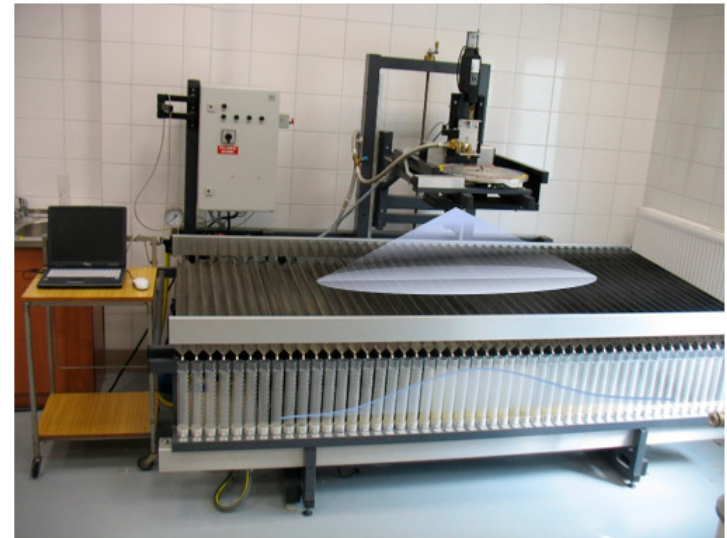
Figure 2. Device for testing the transverse distribution of a single nozzle equipped with a groove table with a groove width of 0.05 m and 50 measuring cups.